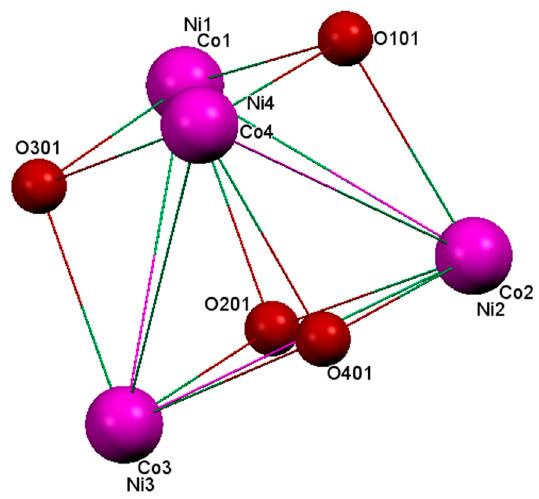
Figure 2. The distorted stellated octahedron composed of interleaved O-and M-based tetrahedral (unit A). The average M–OAc (OAc = CH 3 COO − ) bond distances of complex ( 1 ) of 2.02 Å are longer than that reported for [ Co (cid:2872) O (cid:2872) (dpah ) (cid:2872) (OAc )] (cid:2870) V (cid:2872) O (cid:2869)(cid:2870) ·5 H (cid:2870) O (1.98 Å) and shorter than that reported for [N i (cid:2872) (OCH 3 ) (cid:2872) (OAc ) (cid:2870) (TMB ) (cid:2872) ](BP h (cid:2872) ) (cid:2870) ·4C H (cid:2870) C l (cid:2870) , TMP = 2,5-dimethyl-2,5-diisocyanohexane (2.05 Å) [24,25] and very close to that reported for [ Co (cid:2872) L (cid:2872) (CH (cid:2871) COO) (cid:2870) ] (cid:2870) [BPh (cid:2872) ] (cid:2872) · 0.5H (cid:2870) O [12]. The bond distances of